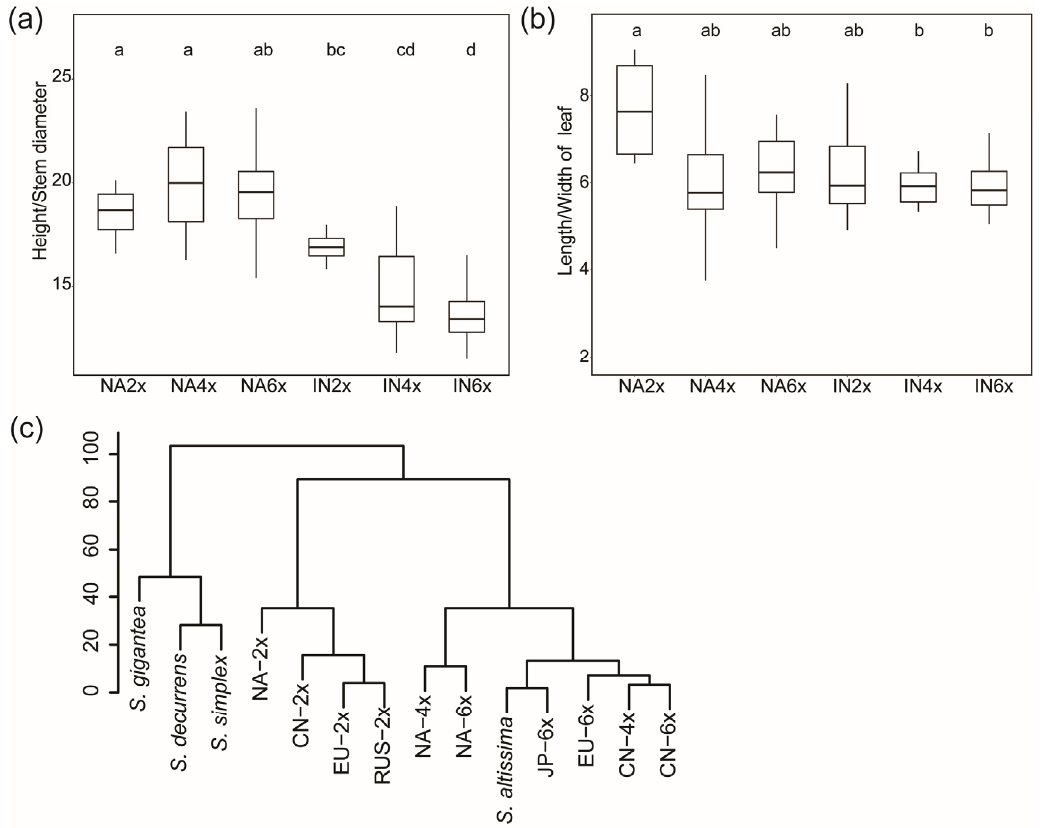
Figure 3. A comparison of morphological traits of different geo-cytotype populations. ( a ) The ratio of length to width, ( b ) ratio of height to stem diameter, ( c ) cluster analysis based on 11 phenotypic traits. CN represents the population of China, EU represents the population of Europe, JP represents the population of Japan, NA represents the population of North America, and RUS represents the population of Russia; S. altissima includes populations of North America and Japan. Different lowercase letters indicate significance.